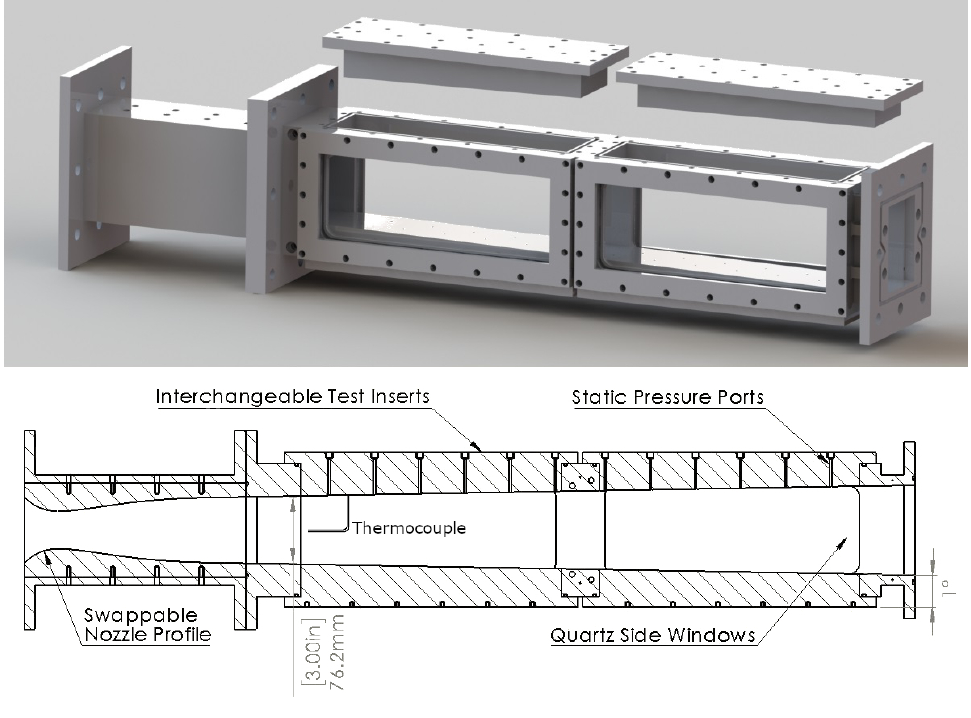
Figure 3. Detailed view of SBR-50 test section: the thermocouple and Pitot tube are posed at same location.